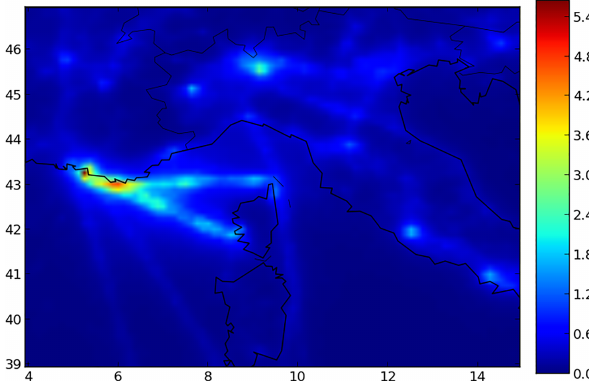
Figure 2. Relative difference (%) of OM 1 concentrations simulated using the emission ratio I/S-VOC/POA = 2.5 and 1.